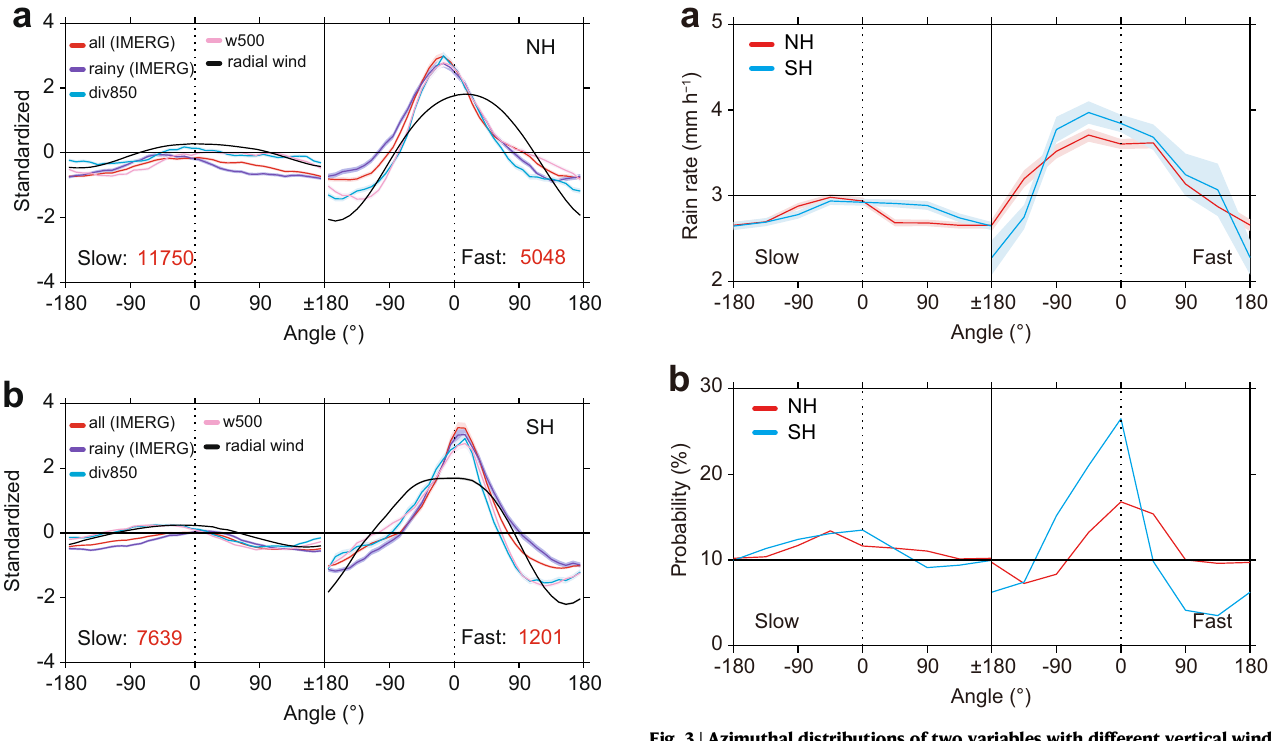
Fig. 2 | Azimuthal distribution of different standardized variables in the two hemispheres. Left and right panels in each sub- fi gure represent these variables in slow-andfast-movingtropicalcyclones(TCs),respectively. a NorthernHemisphere (NH),and b SouthernHemisphere(SH).The x axisrepresentsdifferentangles,asin the schematic diagram shown in Supplementary Fig. 1c; “ 0 ” represents the direc- tion of TC motion, “ ±180 ” represents the reverse of TC motion, and clockwise is positive.Colorsarefordifferentstandardizedvariables:all-pixelsaverage(red)and rainy-pixels average (purple) in TC rain rate, vertical velocity at 500hPa (pink, upward is positive), divergence at 850hPa (blue, convergence is positive), and radialwindat10m(black,in fl owispositive).Rednumbersindicatethesamplesizes used in each plot.